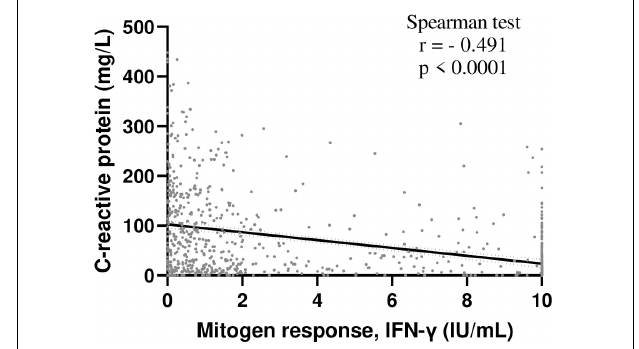
FIGURE 1 | Inverse correlation between INF- γ mitogen response and C-reactive protein levels in hospitalized patients. Correlation between INF- γ mitogen response of QFT and C-reactive protein levels was assessed in hospitalized patients included in the study and with available C-reactive protein data ( n = 825); Spearman test. NB: IFN- γ , interferon γ , QFT, QuantiFERON-TB